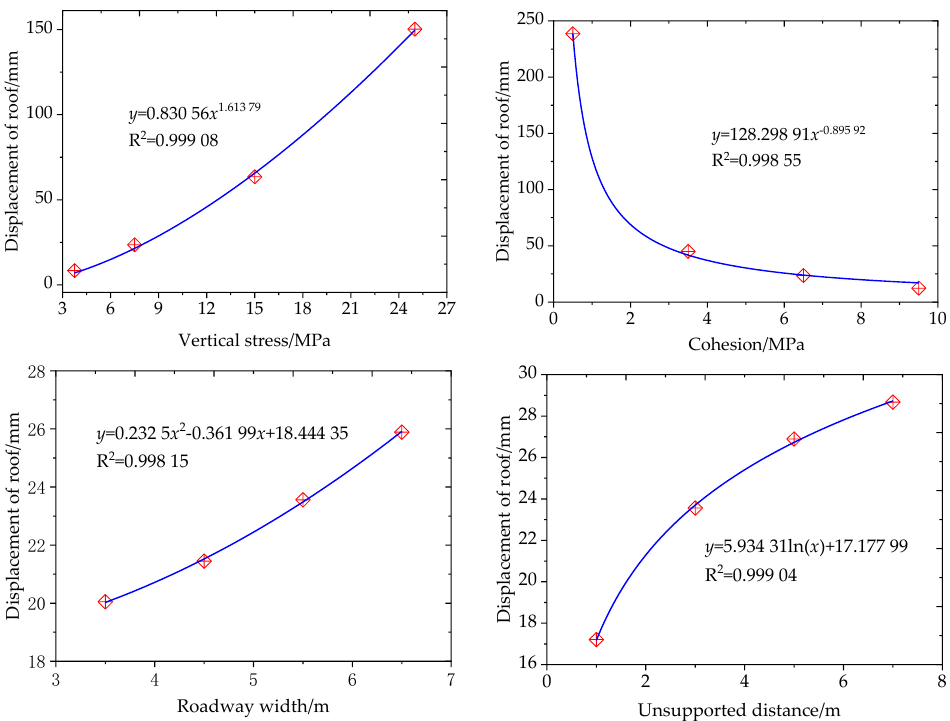
Figure 10. Fitting curve of single factor displacement of heading face roof